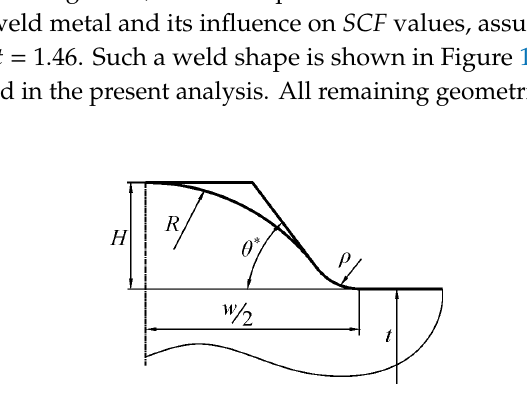
Figure 13. Comparison of two shapes of a butt-welded joint with the same H , w , ρ and θ *